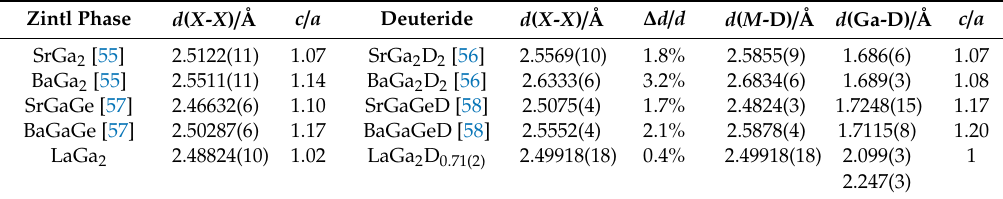
Table 2. Interatomic distances, their relative changes upon deuteration and lattice parameter ratios of Zintl phases M Ga 2 ( M = Sr, Ba, La), Ae GaGe ( Ae = Sr, Ba) and their